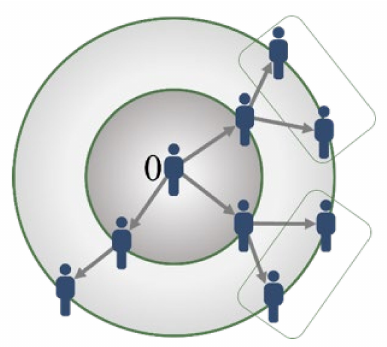
Figure 2. Spread of an epidemic disease from a first infectious case 0 (located at its influence sphere centre) progressively infecting its neighbours in some regions (rectangles) on successive